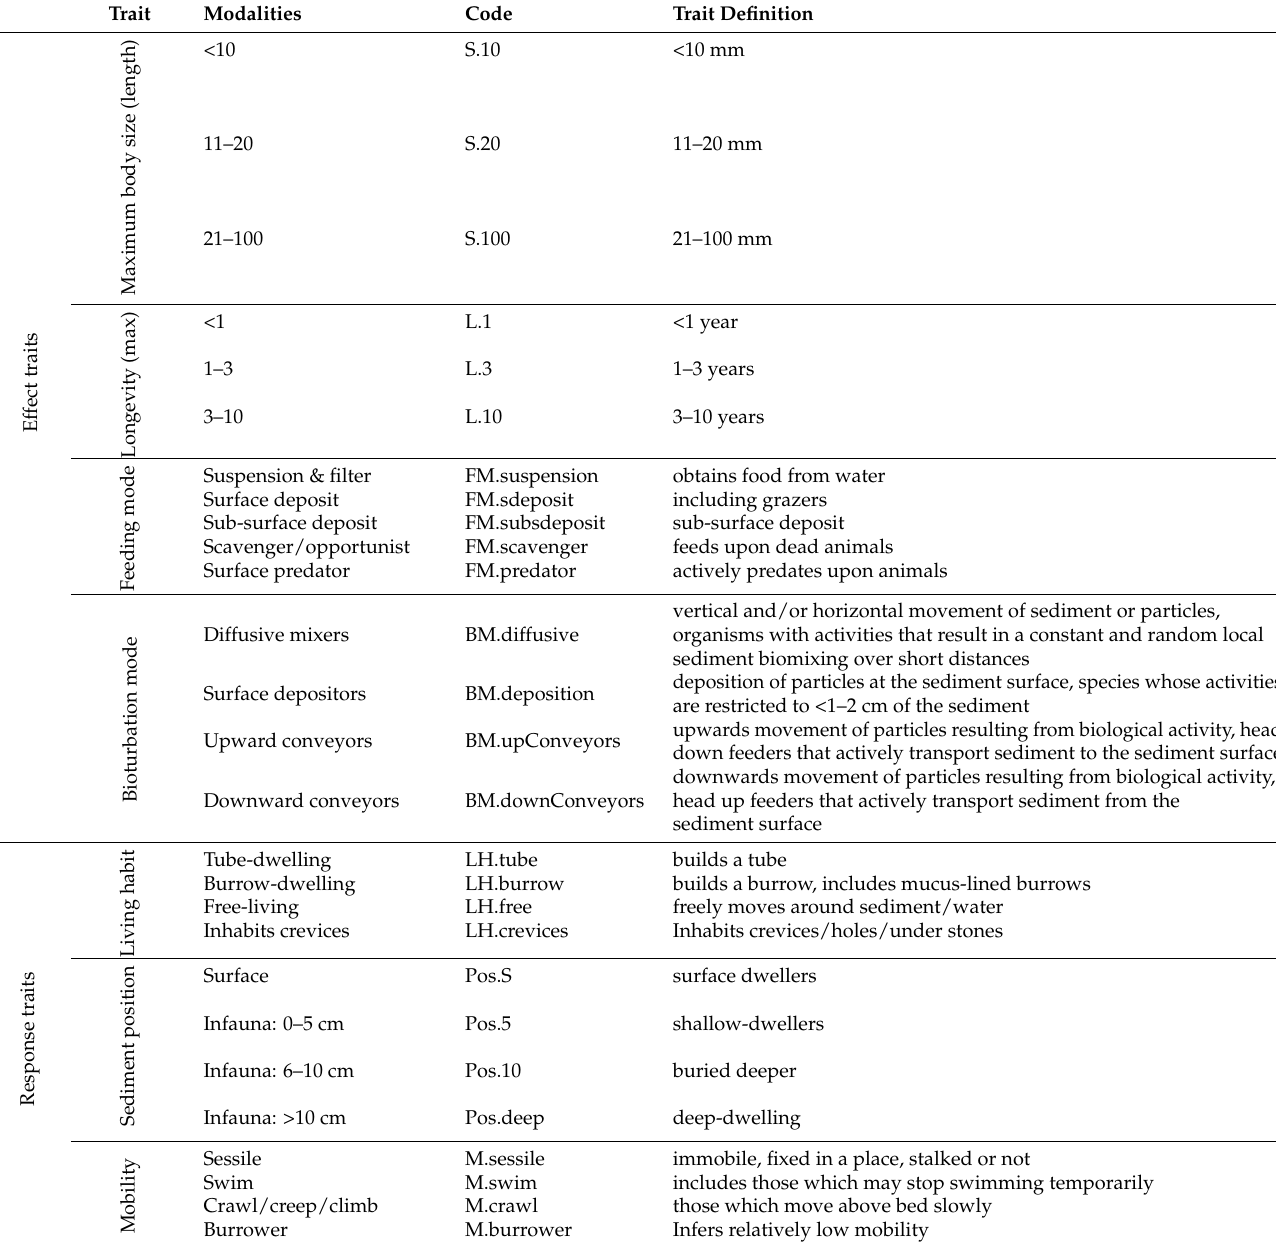
Table 1. Description of traits and trait modalities used in the biological trait